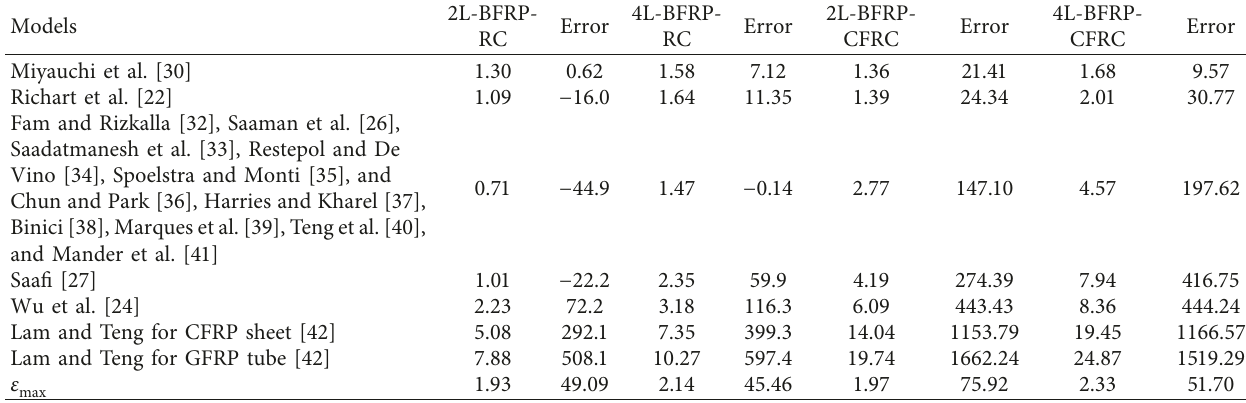
Table 8: Ultimate axial strain prediction of the small-size specimens (units: %).